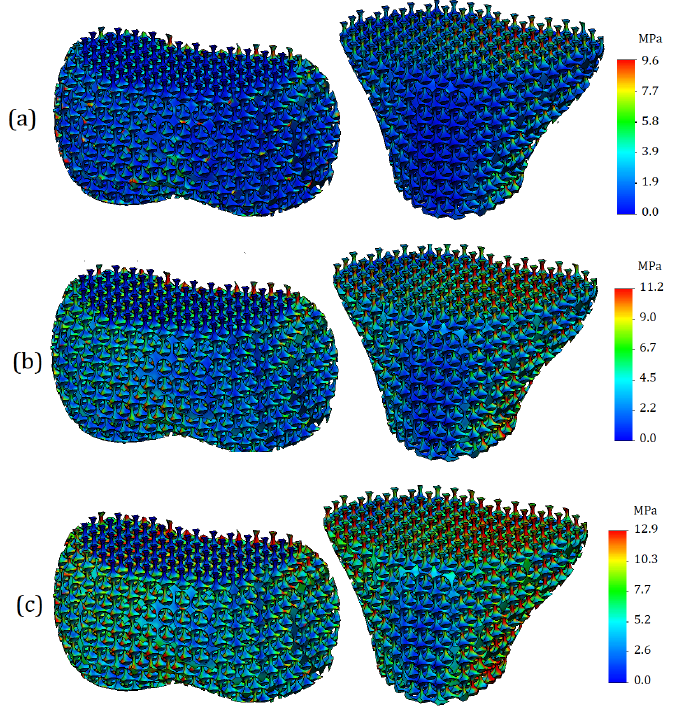
Figure 9. Von Mises stress plots on trabecular bone in case of walking: ( a ) With mild cartilage stiffness; ( b ) With moderate cartilage stiffness; ( c ) With severe cartilage stiffness.